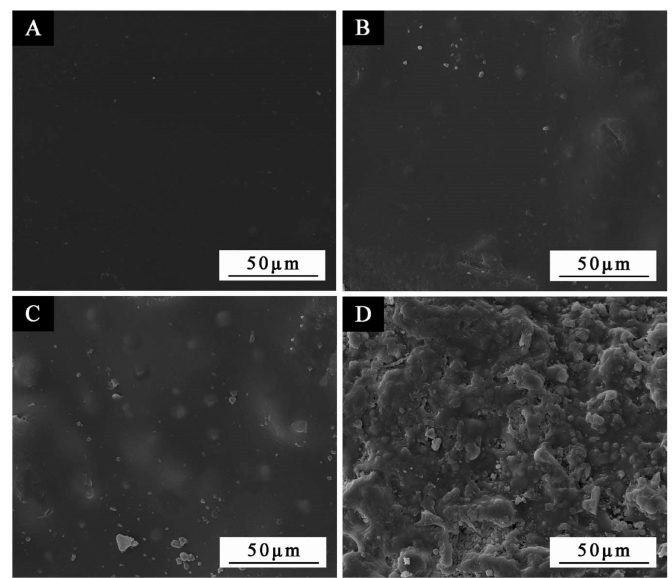
Figure 11. SEM of waterborne primer coating with di ff erent concentrations of microcapsules (core–wall ratio is 0.58:1). ( A ) 0%; ( B ) 5.0%; ( C ) 10.0%; ( D ) 25.0%.